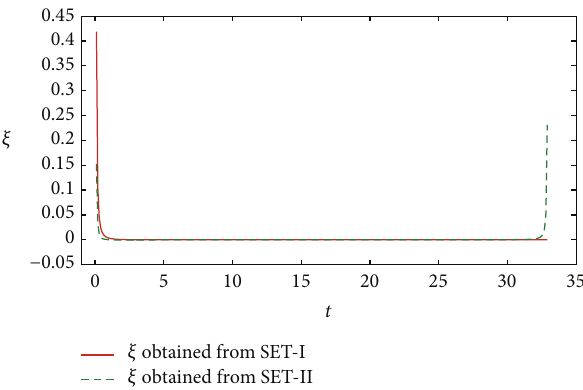
= 1, 𝑅 = 1, 𝑛 = 1 . 6, and 𝑘 = 0 . 097. 1 1